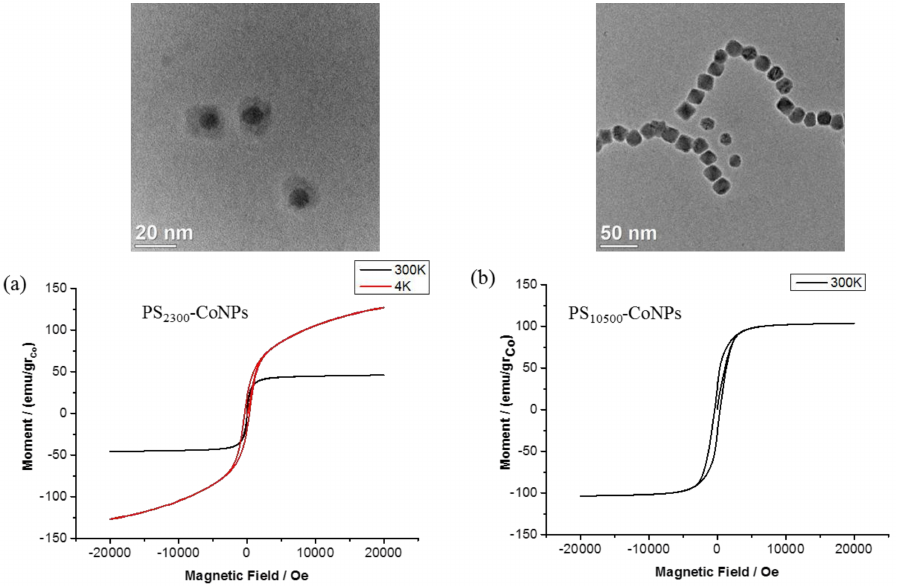
Figure 7. TEM images ( upper ) and field dependence of magnetization of PS–Co NPs ( lower ): ( a ) PS 2300 –CoNPs; ( b ) PS 10500 –Co